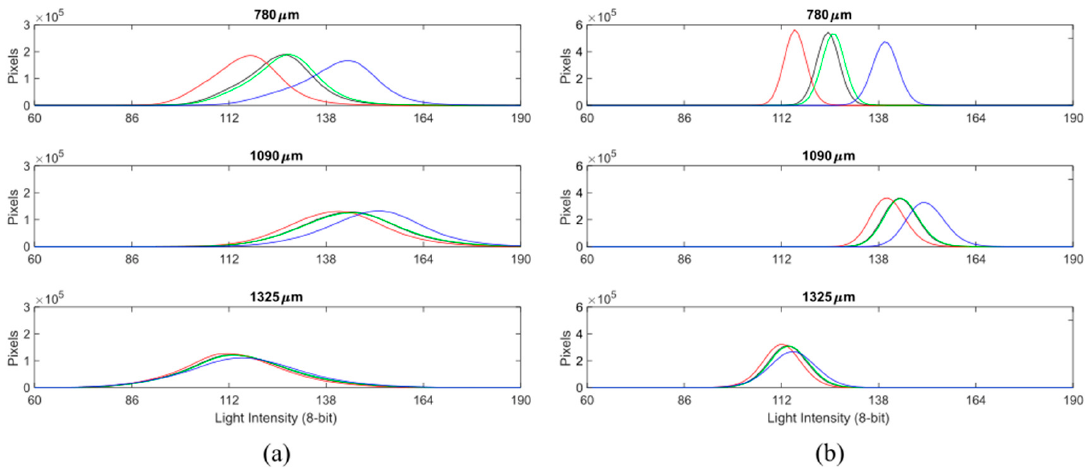
Figure 4. Light intensity distribution of the ( a ) original and ( b ) homogenized training images.